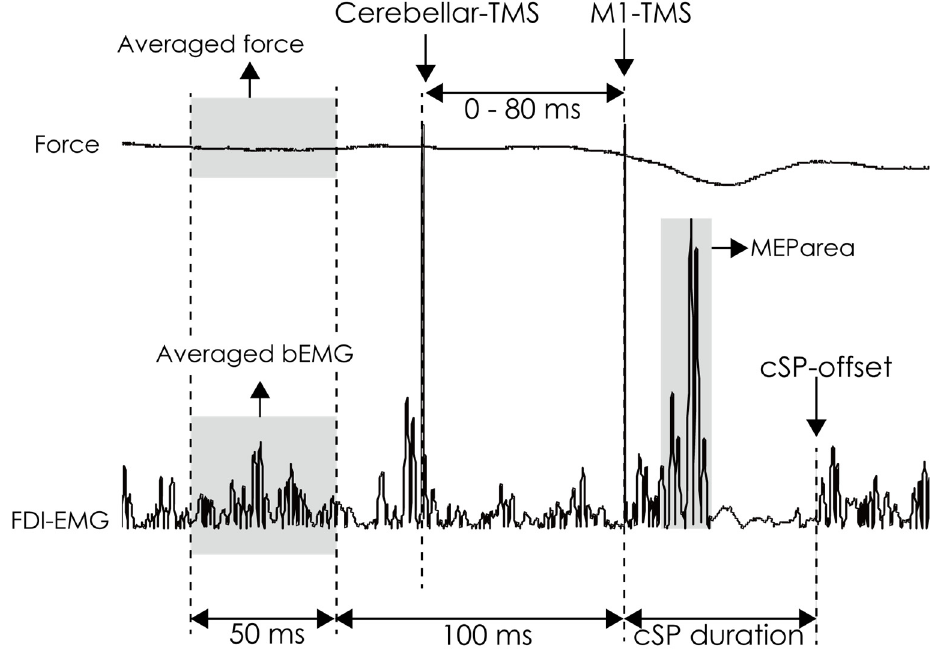
Figure 2. The analysis methods of actual output force and rectified EMG trace. The average force was calculated as the force data 100–150 ms before M1-TMS. The average bEMG amplitude was calculated from the rectified EMG 100–150 ms before M1-TMS. The cSP duration was defined as the time from TMS onset to the time of reappearance of the EMG burst. M1, primary motor cortex; cSP, cortical silent period; EMG, electromyography; bEMG, background electromyography; TMS, transcranial magnetic stimulation.